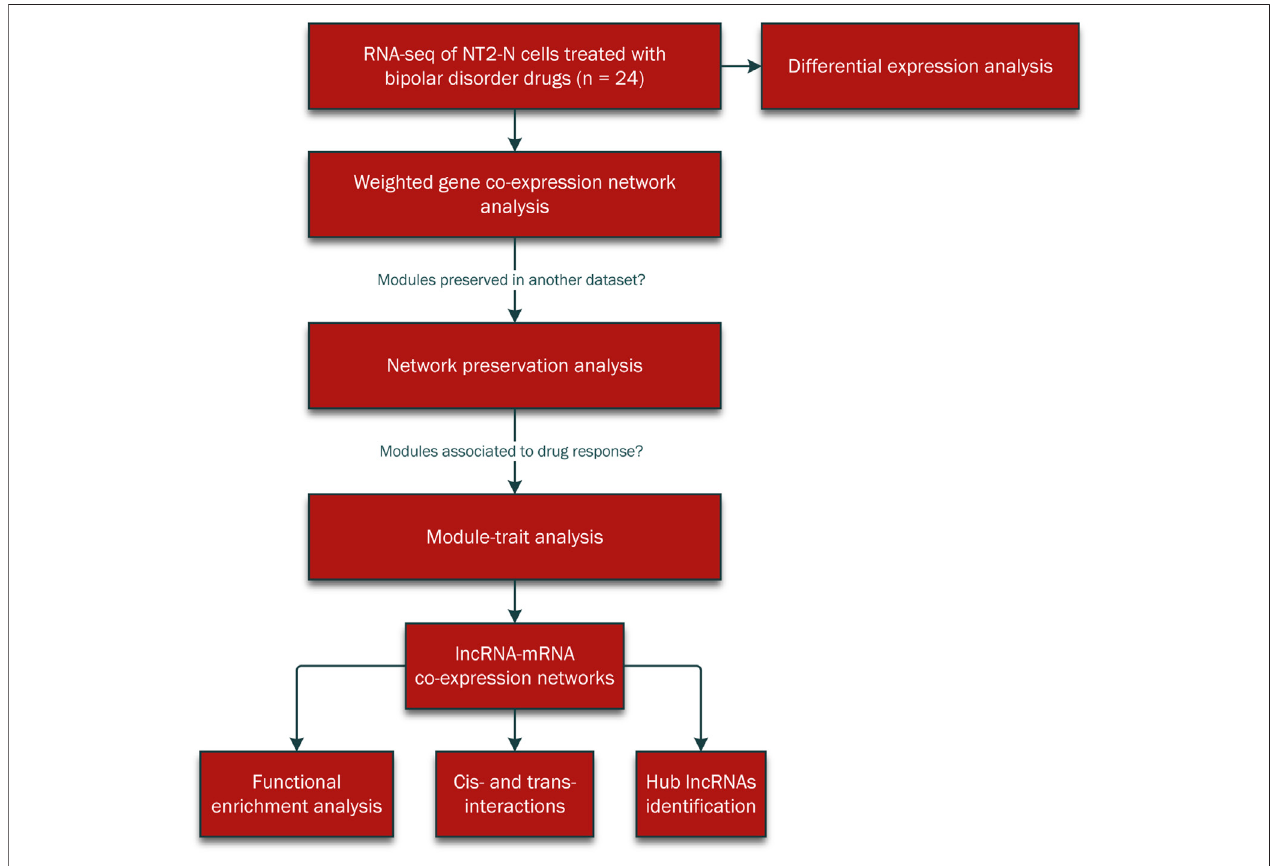
FIGURE 1 | The methodology work fl ow the current